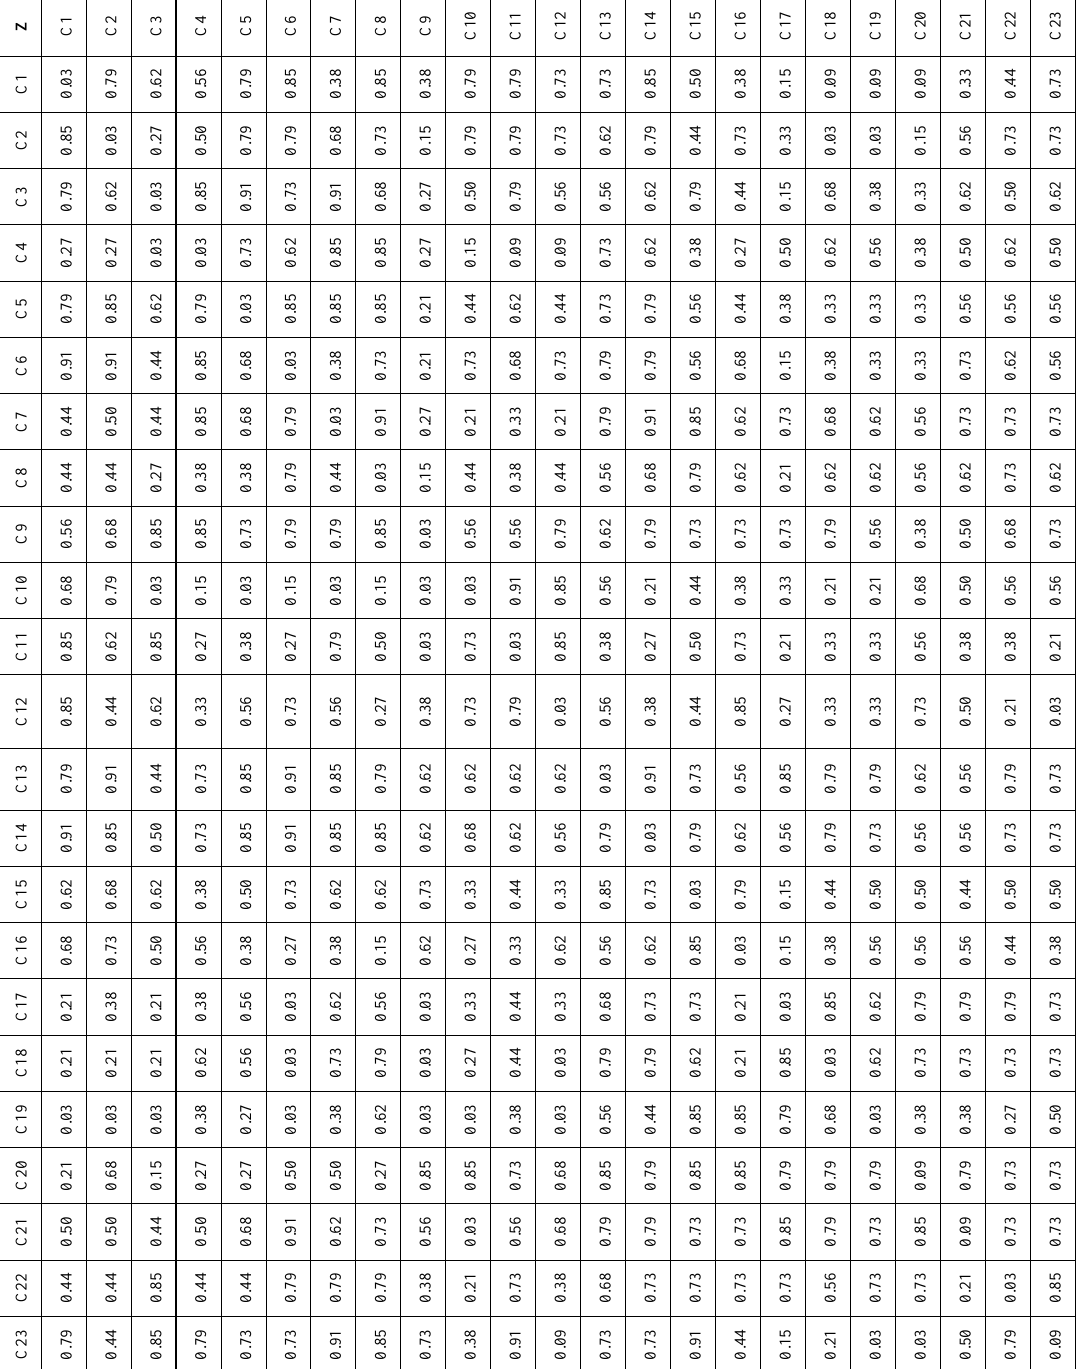
Table 12. Direct relation matrix,